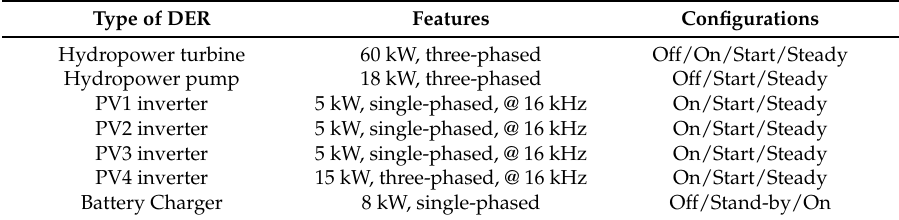
Table 2. List of considered devices, main features and measurement configurations. Type of DER